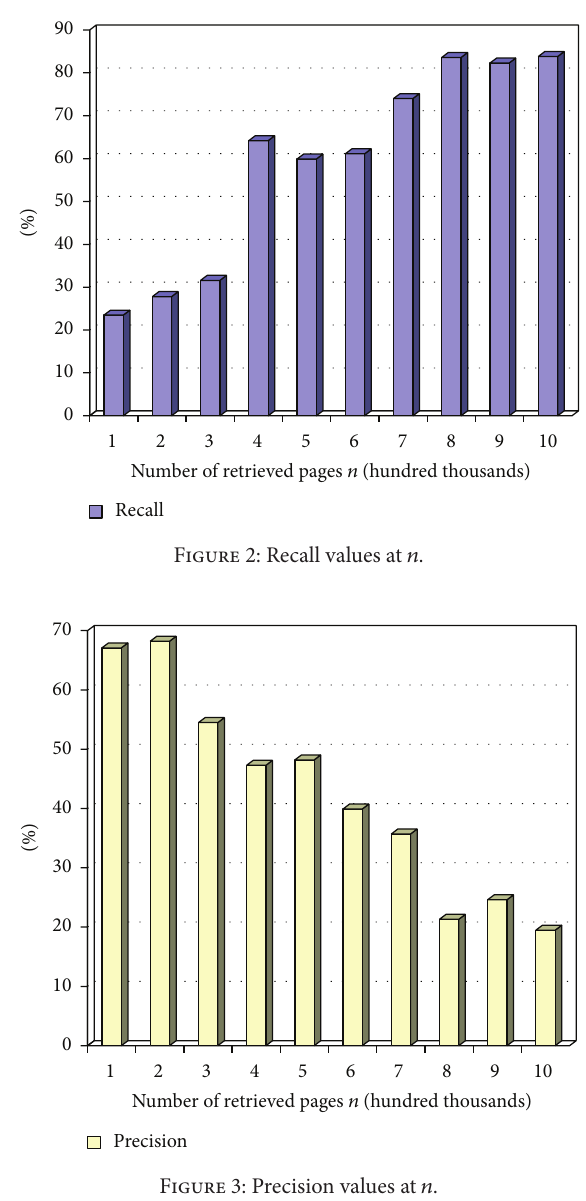
Figure 3: Precision values at 𝑛